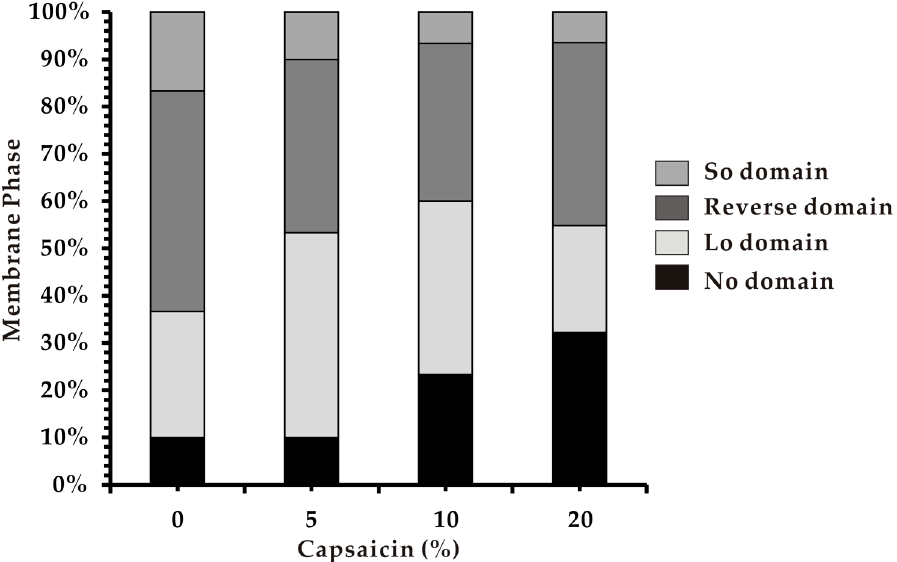
Figure 4. Phase separation in DOPC/DPPC/Chol/Cap systems. Lo: Liquid-ordered; No: No phase separation; So: Solid-ordered.